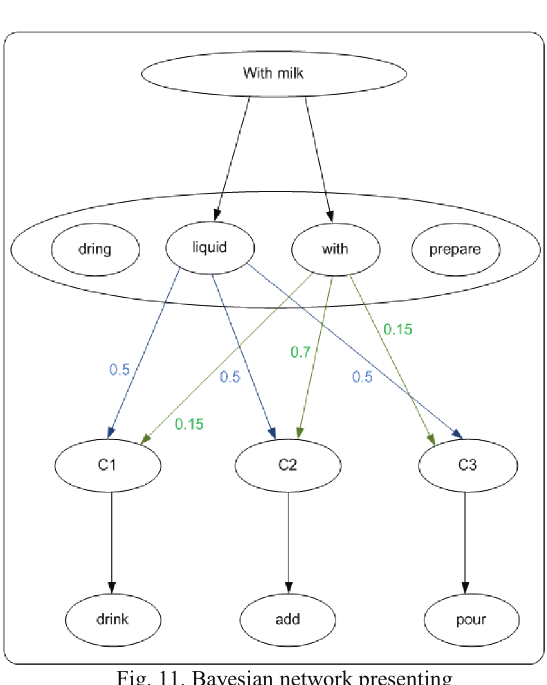
Fig. 11. Bayesian network